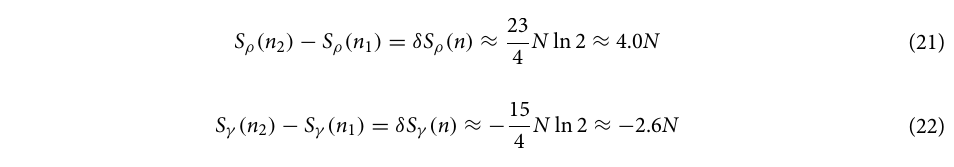
Figure 2. The variation of Probability density | (cid:31) | state ( c ) and 10s state ( d ) of free Hydrogen-like